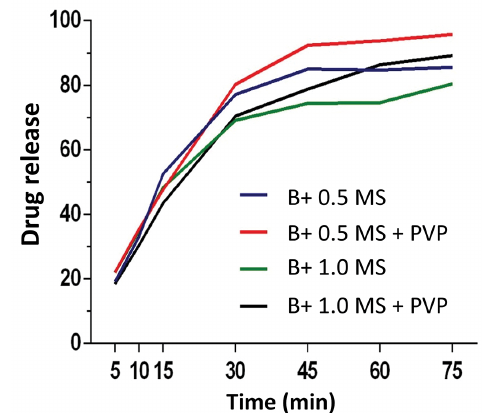
FIGURE 5 - Dissolution profile of lots containing babassu as diluent (B). B + 0.5 MS: Magnesium Stearate 0.5%; B + 0.5 MS + PVP: Magnesium Stearate 0.5% and PVP as a binder; B + 1.0 MS: Magnesium Stearate 1%; B + 1.0 MS + PVP: Magnesium stearate 1.0% and PVP as a